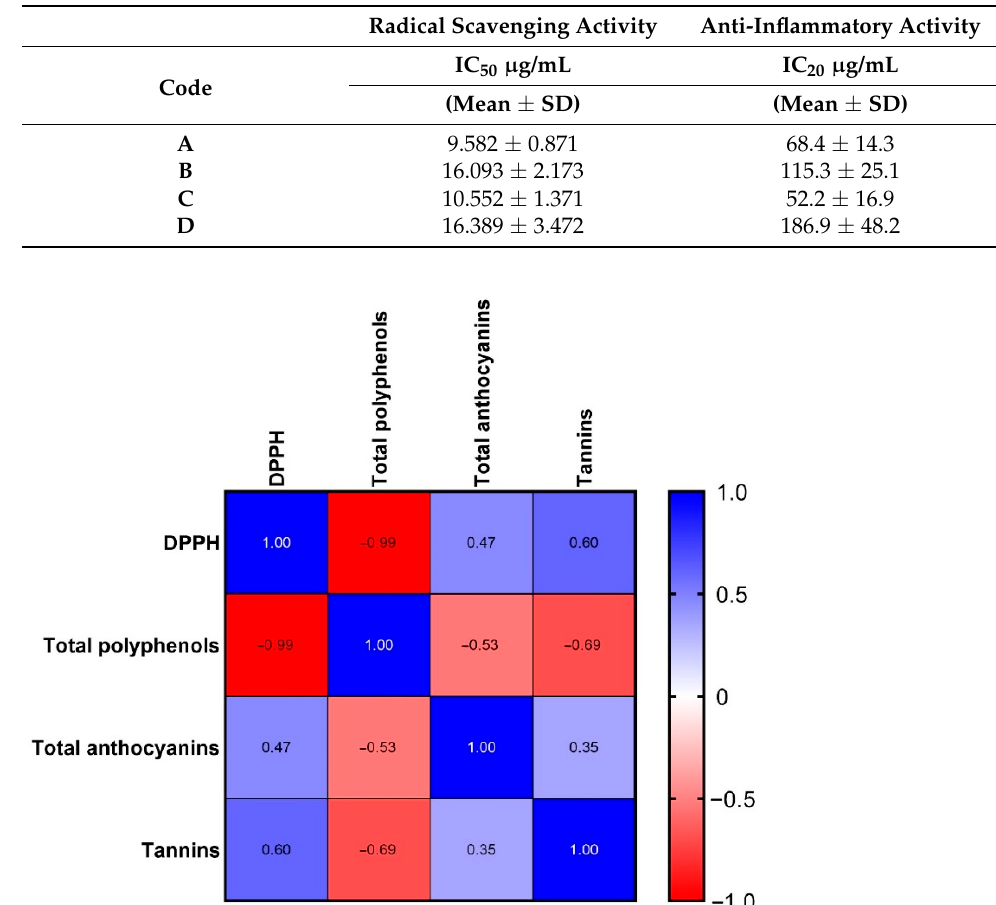
Figure 8. Correlation matrix with Pearson correlation coefficients calculated for DPPH, total polyphenols, total anthocyanins, and tannins. Red and blue colors indicate a negative and positive correlation, respectively. The color intensity indicates the strength of the correlation, as reported in the bar depicted on the right.